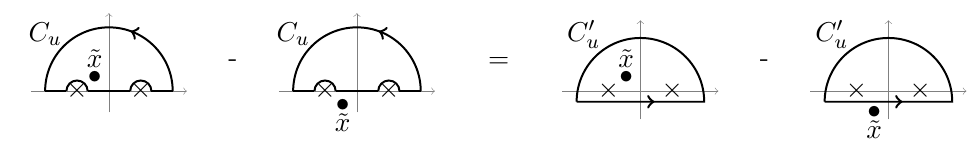
Figure 3 . Equality of subtractions of contours in ‘ i(cid:15) ’